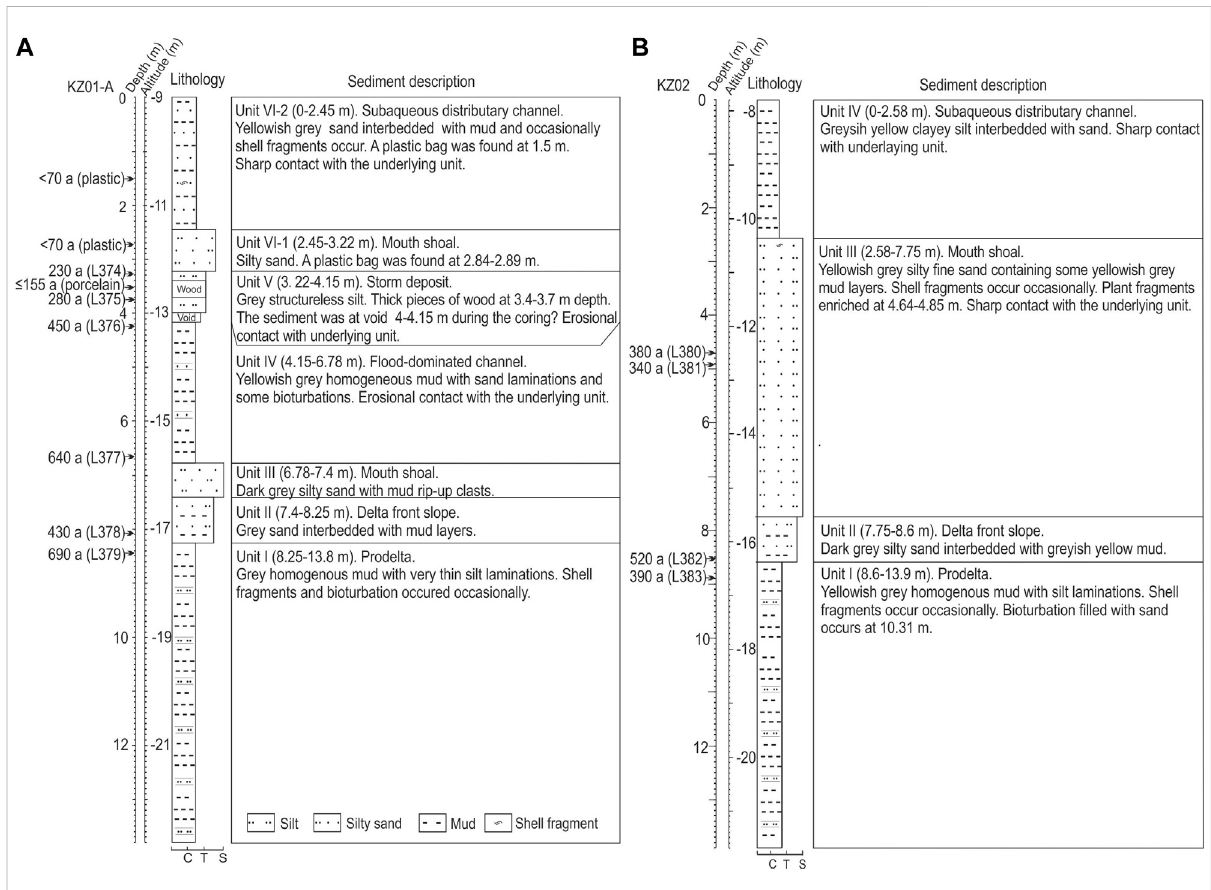
FIGURE 3 Lithostratigraphy and interpretation of sedimentary facies in cores KZ01-A (A) and KZ02 (B) (after Niu et al., 2021). Laboratory numbers of OSL samples, MAM ages of medium-grained quartz, age of porcelain artifacts discovered in the sunken ship, and ages of macro-plastics are indicated on the left side of the pro fi les (after Niu et al., 2021). All ages are calibrated to before 2017